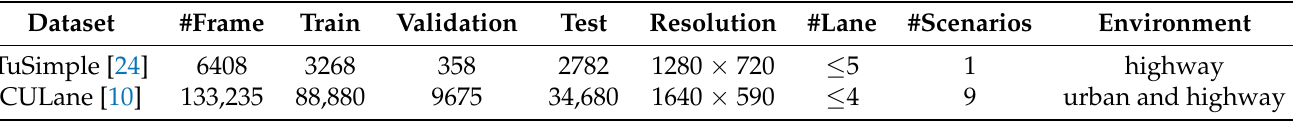
Table 2. Dataset